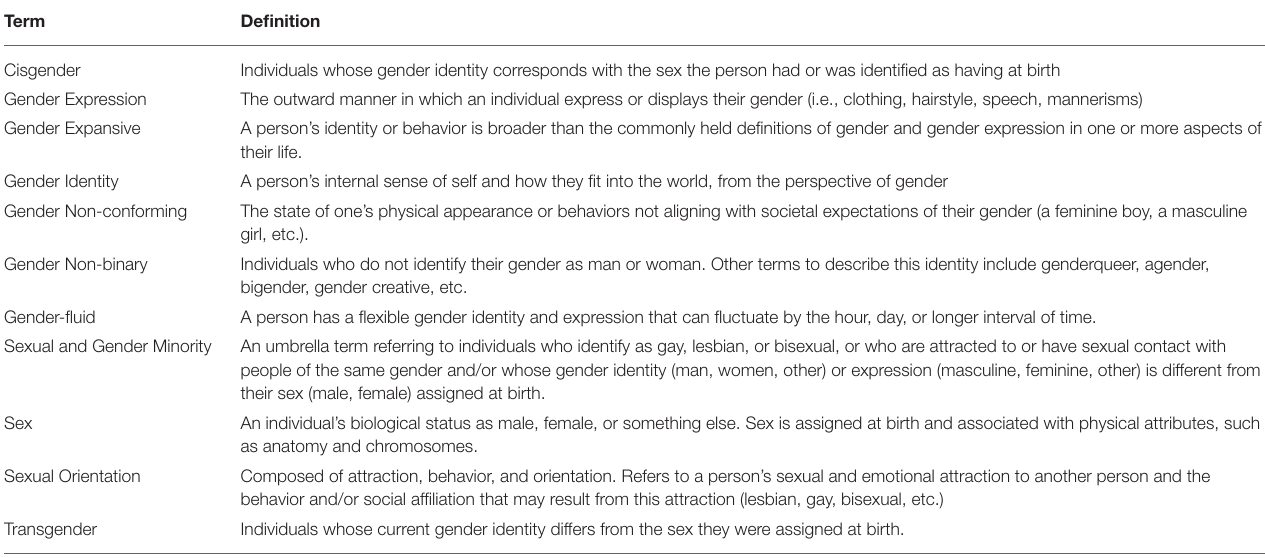
TABLE 1 | Relevant terms and definitions defined by the World Health Organization’s glossary for terms and tools for providing gender-affirmative care. Term